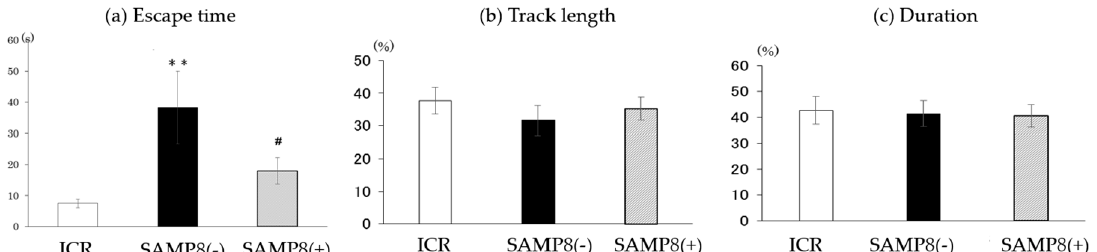
Figure 2. E ff ects of Coriandrum sativum seed extract on the performance on the probe trial by ICR and SAMP8 mice. Values are expressed as the mean ± SEM. ( a ) Time spent in the target quadrant; ( b ) percent of the exploring distance in the target quadrant; ( c ) percent of the exploring time spent in the target quadrant. An asterisk indicates a significant di ff erence compared to the ICR group ( ** p < 0.01). A hash mark (#) indicates a significant di ff erence compared to SAMP8( − ) mice. ICR, Institute of Cancer Research; SAMP8( − ), SAMP8 mice without C. sativum supplementation; SAMP8( + ), SAMP8 mice with C. sativum supplementation.